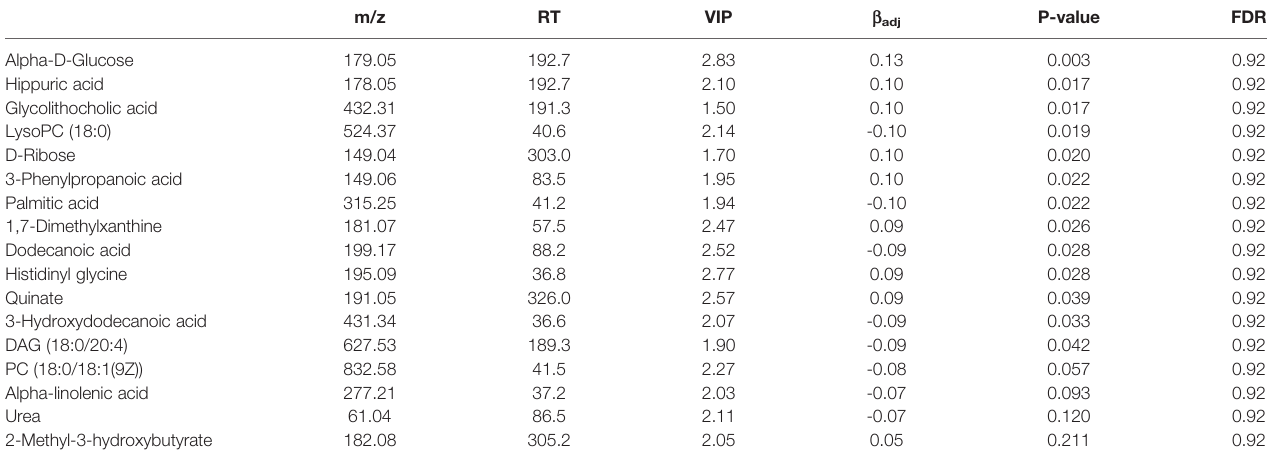
TABLE 5 | BMD associated serum metabolites. m/z RT